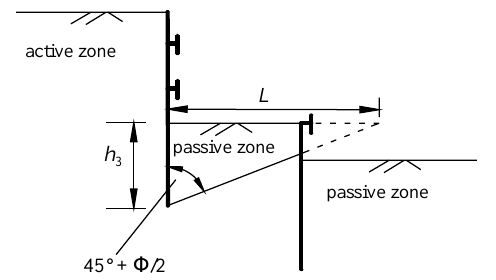
Fig. 7. Interaction between the walls